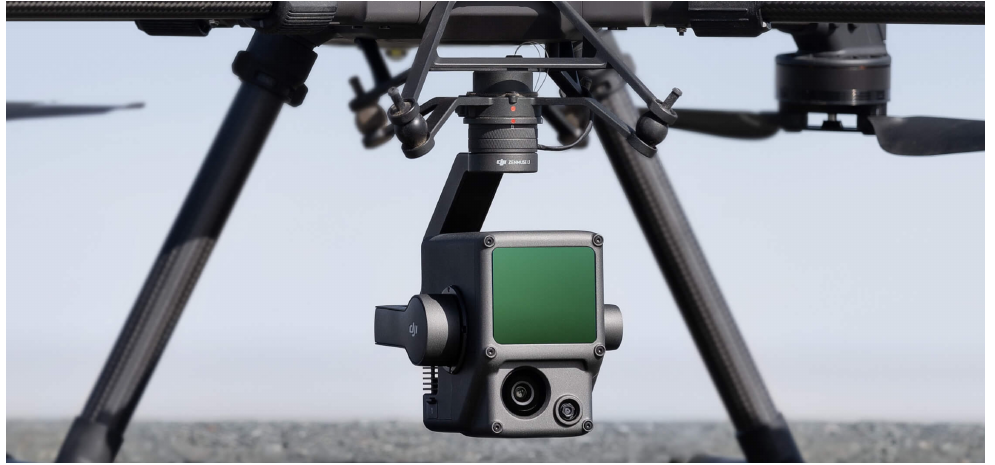
Figure 2. Zenmuse L1 LiDAR sensor, anchored to a gimbal and a DJI Matrice 300 RTK drone (image from www.dji.com accessed on 10 July